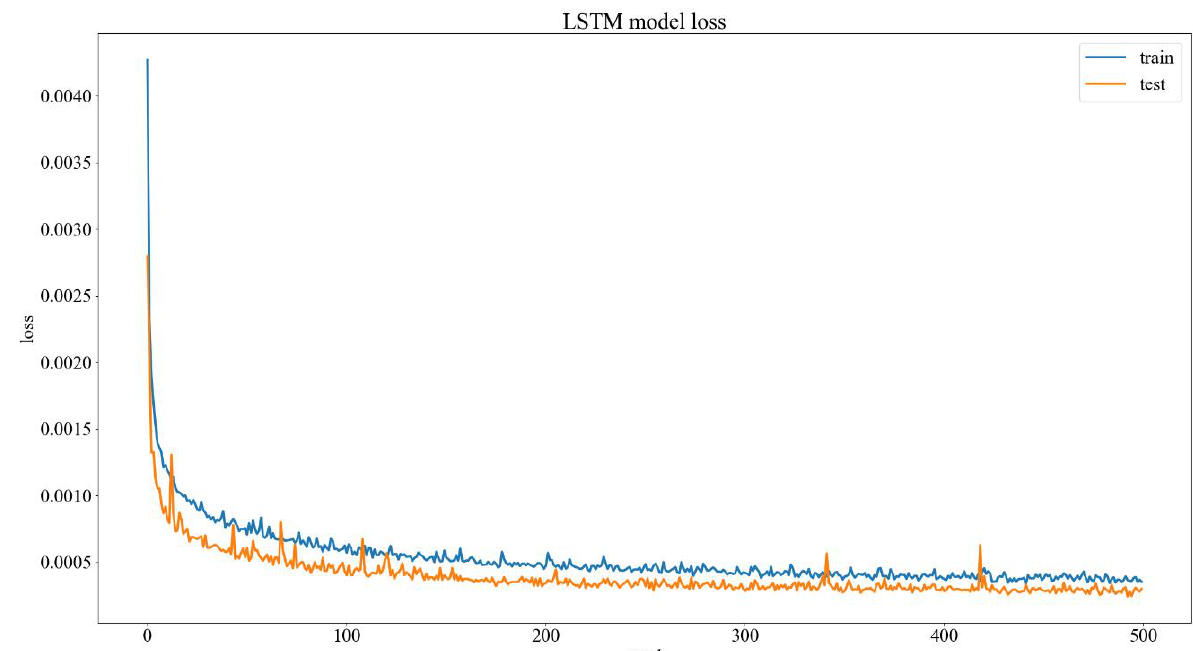
Figure 11. LSTM multi-output prediction for different trajectories at variable speeds.